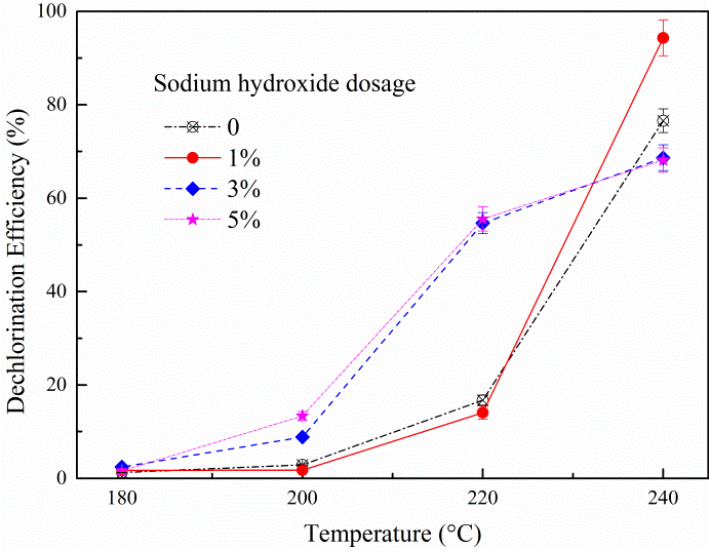
Figure 2. Effect of temperature on HT dechlorination of PVC.